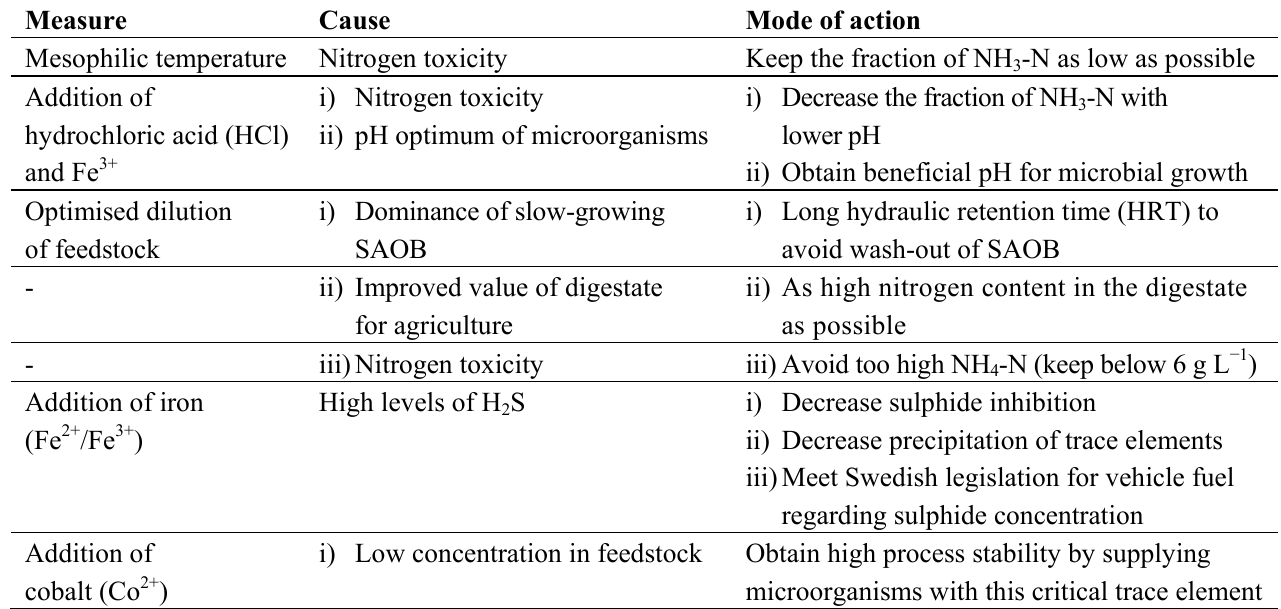
Table 1. Summary of the measures introduced to optimise anaerobic digestion of thin stillage at the Norrköping biogas plant, the underlying cause and the mode of